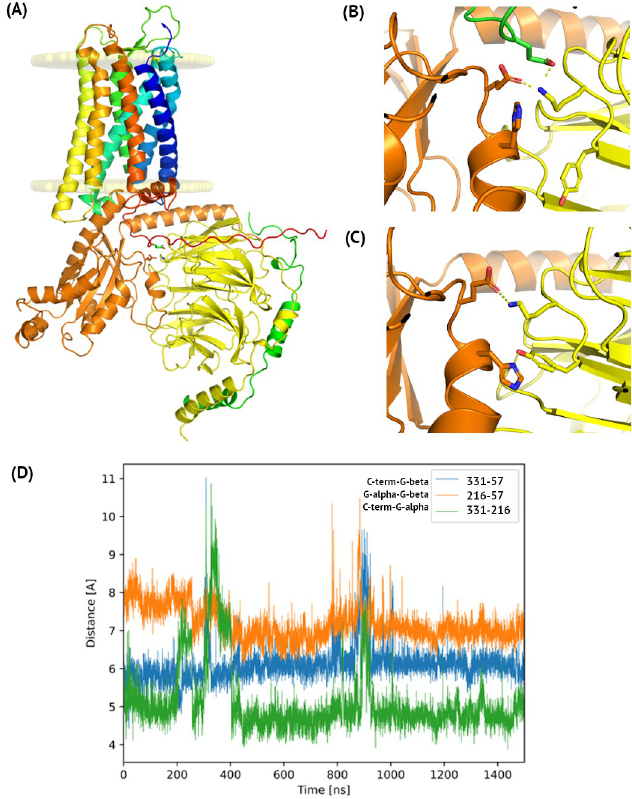
Fig 4. The C5aR1 –G α –G β interface observed in microsecond MD simulations. (A) The full simulation system with the indicated lipid bilayer. Here, the structure of the complex was extracted from the last frame of the microsecond MD simulation started from active C5aR1 based on FPR2 with G i . A flexible, unstructured C-terminus of C5aR1 (shown in red) did not form any regular secondary structures during the simulation. (B) Details of the C5aR1 –G α –G β interface. Three polar amino acids were close to each other during the whole simulation: Glu331 (green), Glu216 (orange) and Lys57 (yellow) (C5aR1, G α , and G β , respectively). A similar pattern of interface interactions between Glu (G α ) and Lys (G β ) residues was observed in the cryo-EM structure of active FPR2 with G i (C). Yet, this structure lacks the receptor C-terminus and instead, only an additional hydrogen bond between His (G α ) and Tyr (G β ) was observed. (B) A distance plot confirming the three-residues’ interaction in C5aR1. Here, sequence numbering was adjusted to P21730 (C5aR1), P63096 (G α ), and P62873 (G β ) entries in